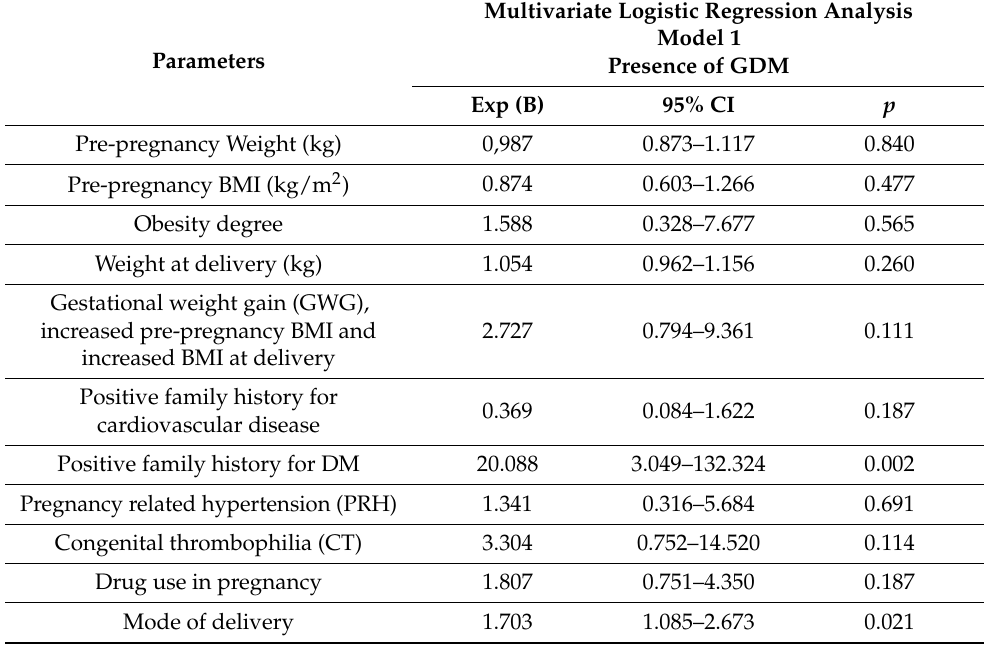
Table 4. Multivariate regression analysis of maternal parameters due to the presence of GDM ( N = 203).